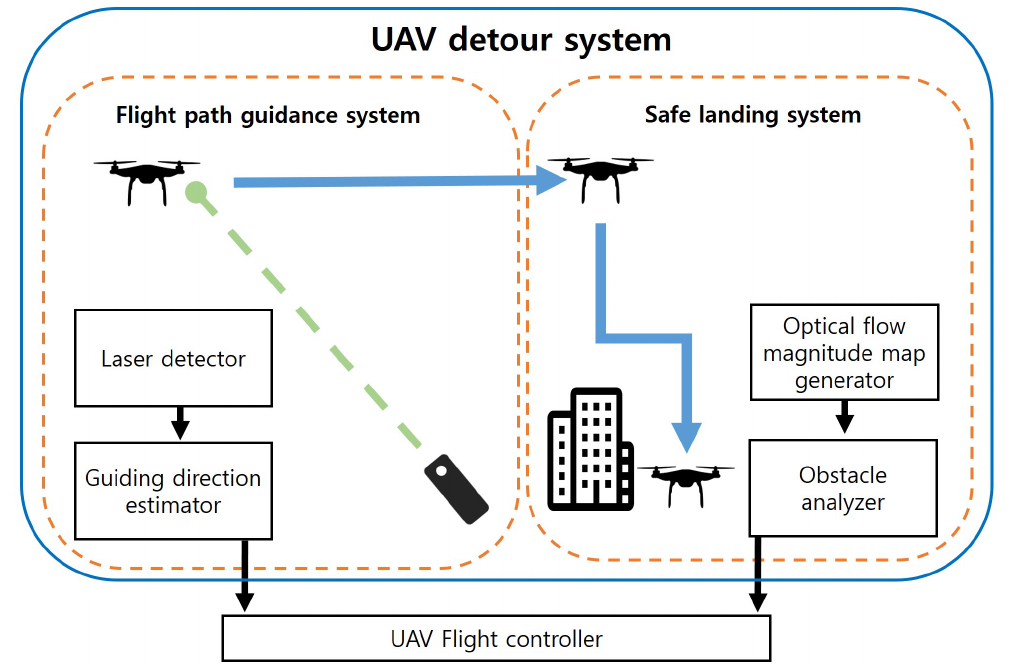
Figure 7. Overall systems and